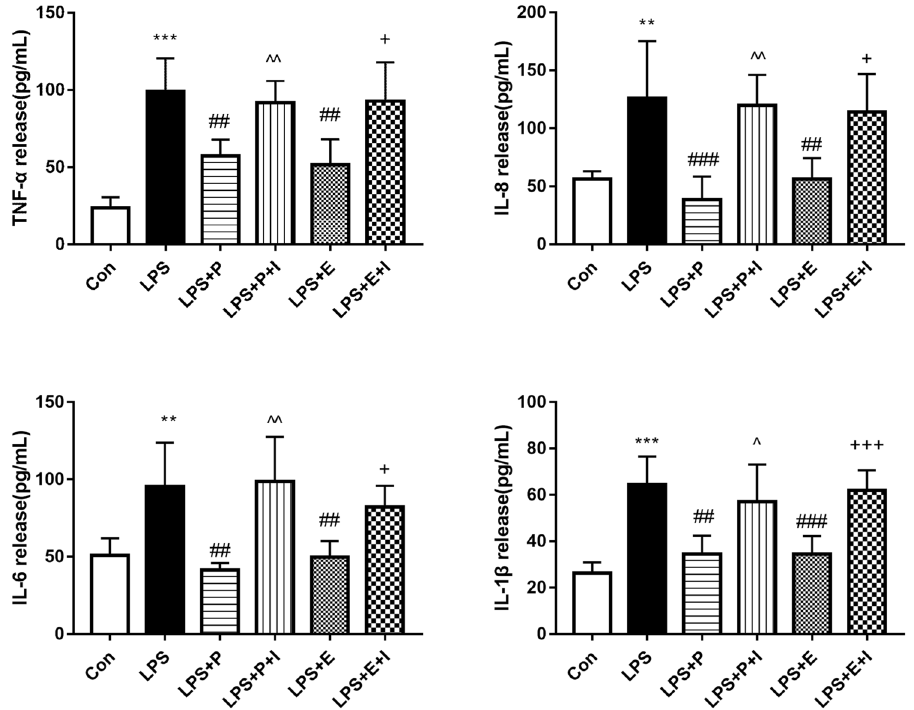
Figure 8. Effects of psoralen on the expression of inflammatory factors protein. hPDLCs were divided into 6 groups: Con, control group; LPS, LPS (1 μg/mL) group; LPS + E, LPS and estrogen (10 –8 M) group; LPS + P, LPS and psoralen (12.5 μg/mL) group; LPS + E + I, LPS and estrogen (10 –8 M) and ICI (1 μM) group; LPS + P + I, LPS and psoralen (12.5 μg/mL) and ICI (1 μM) group (* p < 0.05,** p < 0.01, *** p < 0.001 compared with the control group, # p < 0.05 compared with the LPS group, ^ p < 0.05, ^^ p < 0.01, compared with the LPS + P group, + p < 0.05, ++ p < 0.01 compared with the LPS + E